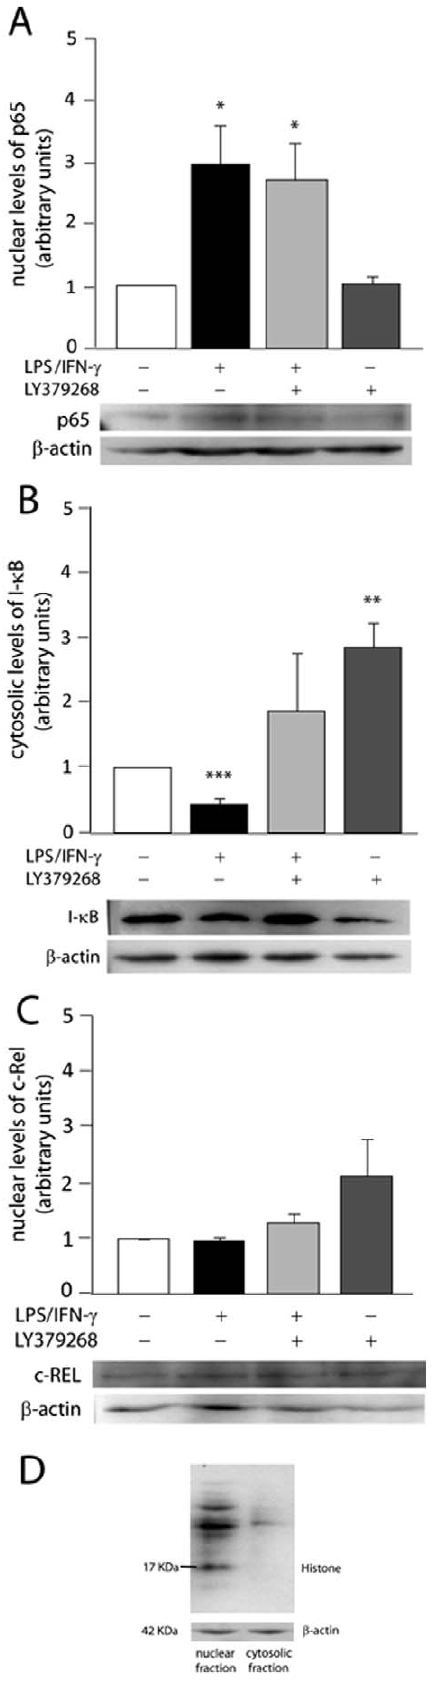
Figure 2. Expression of NF- k B family proteins. Astrocyte primary cultures were exposed to LPS/IFN- c (1 m g/mL/50 ng/mL) 6 100 m M LY379268 for 30 min and nuclear and cytosolic proteic extracts were used for western-blots of p65 (A), I k B a (B) and c-Rel (C). Values of OD from bands were normalized to the internal control b -actin and data expressed relative to control group. Bars represent the mean 6 SEM of 5–6 (A and B) or 3 (C) independent experiments. *p , 0.05, **p , 0.01, ***p , 0.001 versus control. (D) The purity of nuclear and cytosolic fractions was assayed by western-blot for nuclear histone.